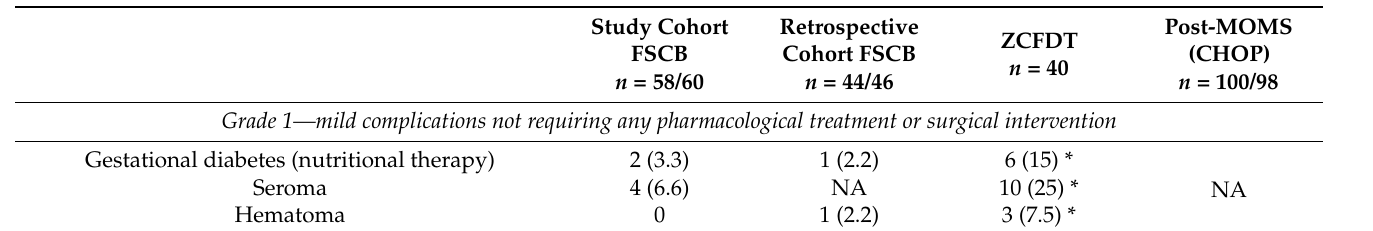
Table 2. Comparison of operative and perinatal complications according to the Clavien-Dindo classification in all